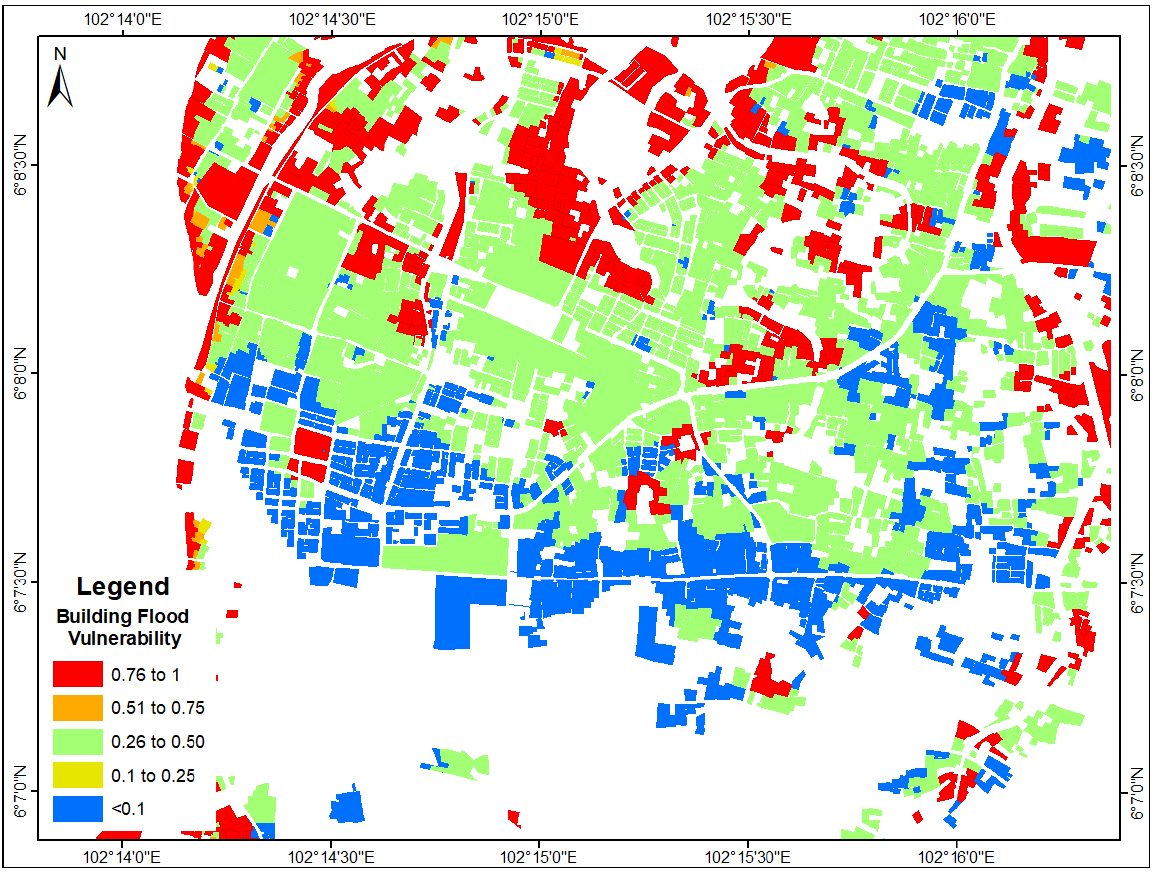
Figure 3: Example of micro-scale flood vulnerability map of some part Kota Bahru, produced using IBM (a preliminary